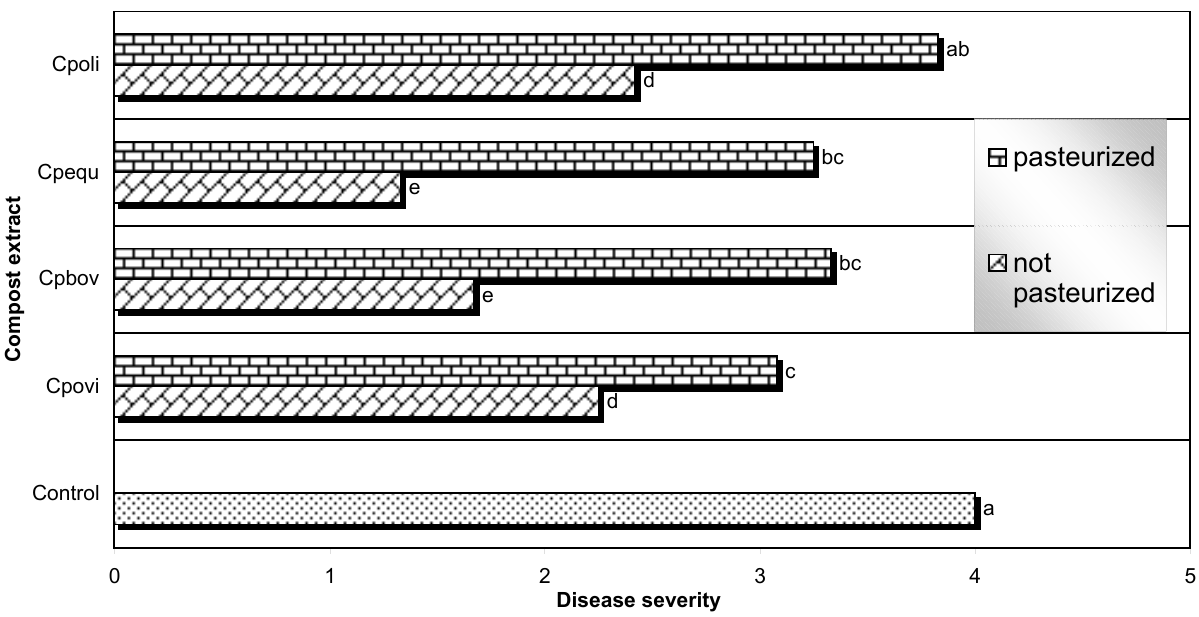
Fig. 4. Effect of pasteurization of compost extracts on their control of grey mould. Controls were sprayed with tap water before inoculation with Botrytis cinerea . For disease scale and statistical analysis of data see caption in Fig.